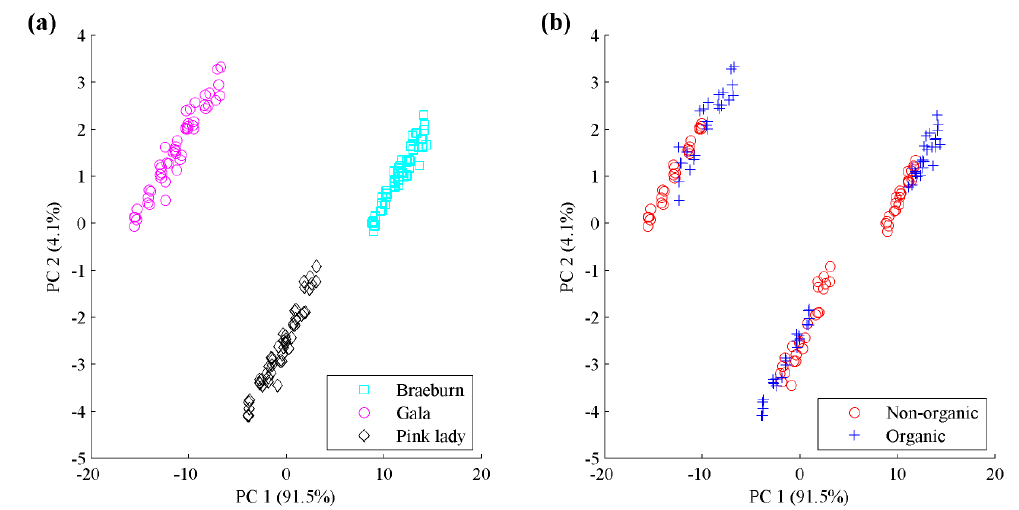
Figure 8. Score plots of the first two dimensions of PCA of apple data: ( a ) Braeburn, Gala and Pink lady species; ( b ) Non-organic and organic types.